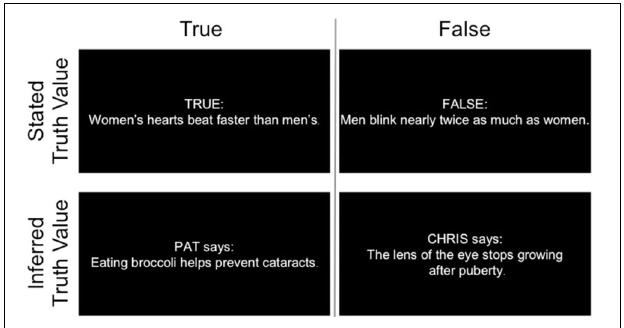
FIGURE 1 | Examples of encoding stimuli used in each condition.